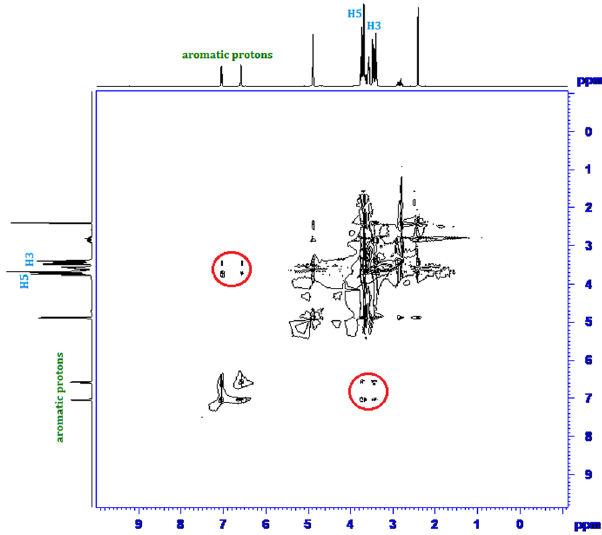
Figure 9. 2D ROESY NMR spectra of the solid (SNP + β -CD) system.